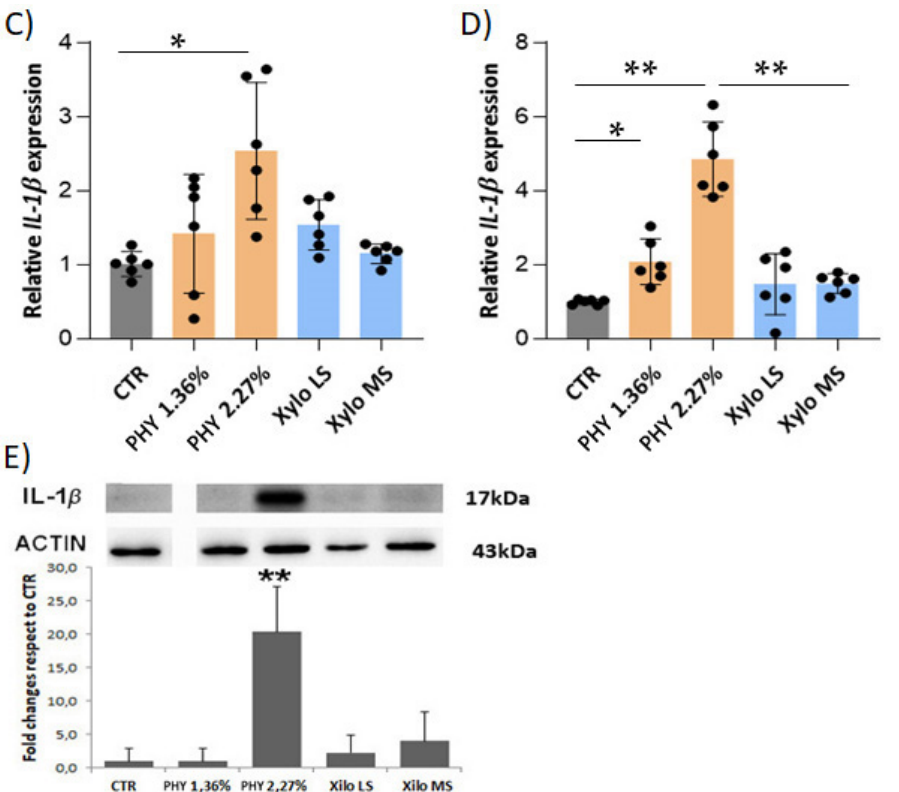
Figure 8. Expression of inflammatory markers in mesothelial and endothelial cells. IL-6 ( A , B ) and IL-1 β ( C , D ) gene expression. The analysis was performed as described in Figure 5. ( A ) CTR vs. PHY 1.36% p = 0.0021, CTR vs. PHY 2.27% p < 0.0001, CTR vs. Xylo MS p = 0.0009, PHY 2.27% vs. Xylo MS p = 0.0021; ( B ) CTR vs. PHY 1.36% p = 0.0122, CTR vs. PHY 2.27% p = 0.0036, PHY 1.36% vs. Xylo LS p = 0.0079, PHY 2.27% vs. Xylo MS p = 0.0022; ( C ) CTR vs. PHY 2.27% p = 0.0066; ( D ) CTR vs. PHY 1.36% p = 0.0482, CTR vs. PHY 2.27% p < 0.0001, PHY 2.27% vs. Xylo MS p < 0.0001 * p < 0.05, ** p < 0.001.